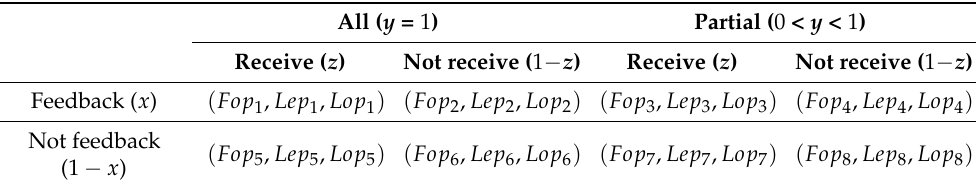
Table 2. Payoff matrix of followers, leaders, and loners. All ( y = 1 ) Partial ( 0 < y < 1 ) Receive ( z